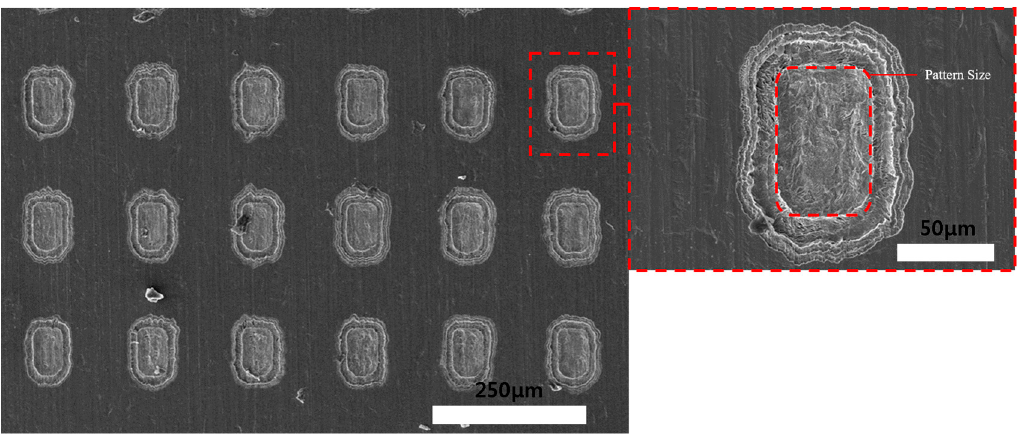
Figure 7. SEM images of Invar thin film after wet etching (photoresist coating face etching) for 5 min.